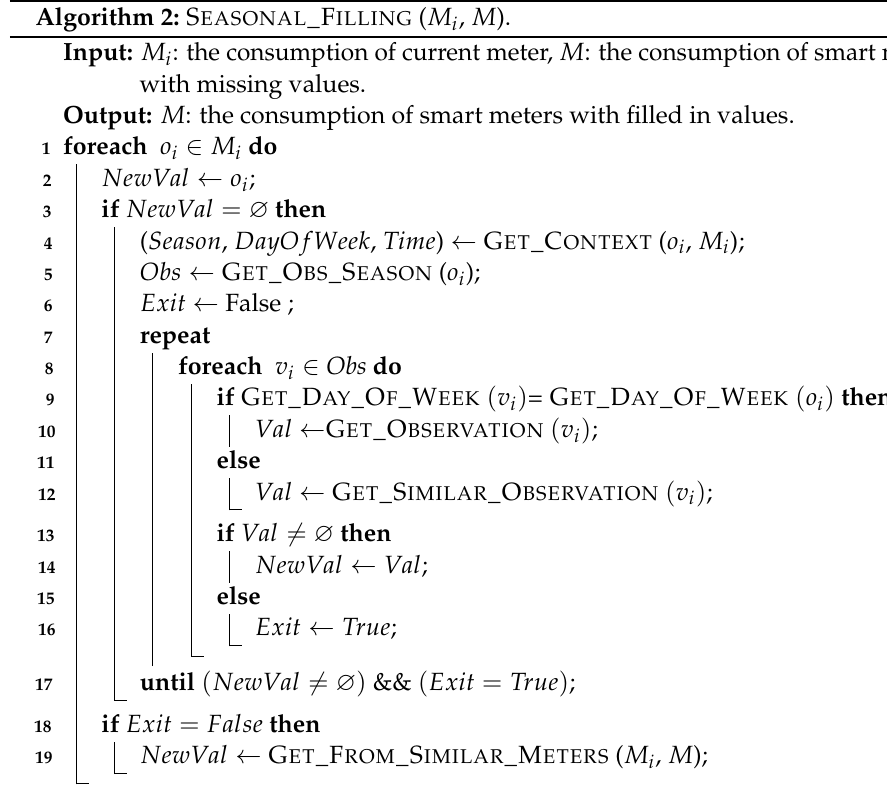
Algorithm 2: S EASONAL _F ILLING ( M i , M